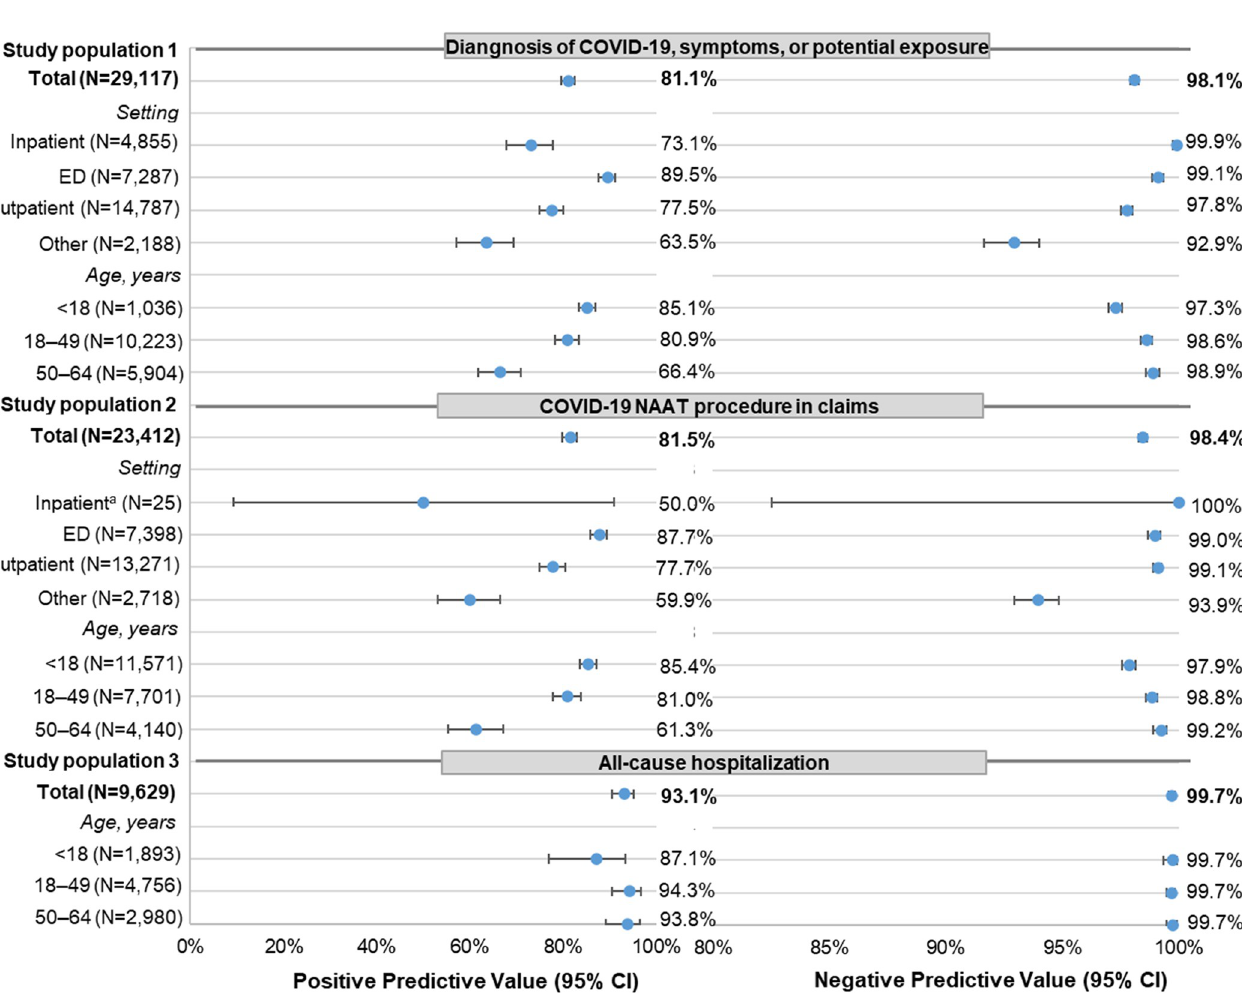
Fig 5. Performance characteristics (PPV/NPV) of diagnosis code U07.1 in claims data among individuals with Florida Medicaid. Outpatient encounters include all outpatient services because specific places of service (e.g., office, hospital outpatient) cannot be identified in the data. Care setting was defined using a hierarchy if services at multiple settings were found on the index event date: inpatient, ED, outpatient, other. See S2 Table 2B in S2 File for the full results with exact CIs. The PPVs for study population 1 (inpatient setting at index event) and population 3 (all-cause hospitalization) are different because study population 1 episodes include diagnoses outside the hospitalization. CI confidence interval, ED emergency department, ICD-10-CM International Classification of Diseases, Tenth Revision, Clinical Modification, NAAT nucleic acid amplification test, PPV positive predictive value, SARS-CoV-2 severe acute respiratory syndrome coronavirus 2. a Metric calculation used cell size < 5. Data source: OneFlorida Data Trust linked Medicaid-EHR, April 1–November 30,